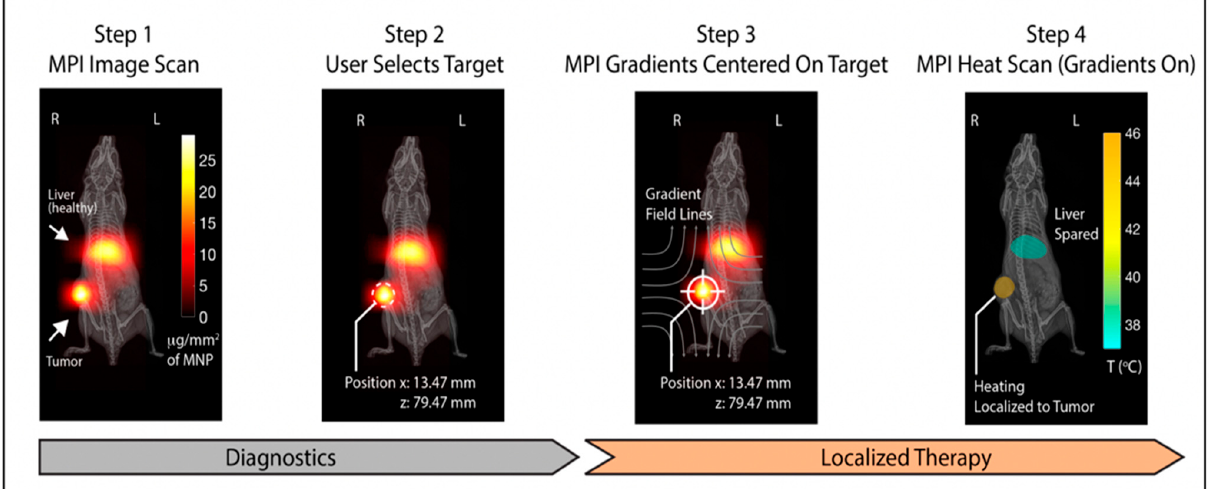
Figure 8. Workflow of treatment with SPIONs accumulated in liver and tumor of a U87MG xenograft mouse. Step 1: MPI image scan showing high contrast visualization of biodistribution of SPIONs in healthy organs (liver) and region of concern (tumor). Imaging parameters are set such that SPIONs do not generate heat; Step 2: Tumor region is selected to localize hyperthermia; Step 3: The magnetic field gradients are set such that FFR (field-free region) is centered at tumor; Step 4: Heat scan performed such that heating is localized at tumor (FFR) and sparing the nearby liver. Reproduced with permission from Ref . [133]. Copyright 2018 American Chemical Society.